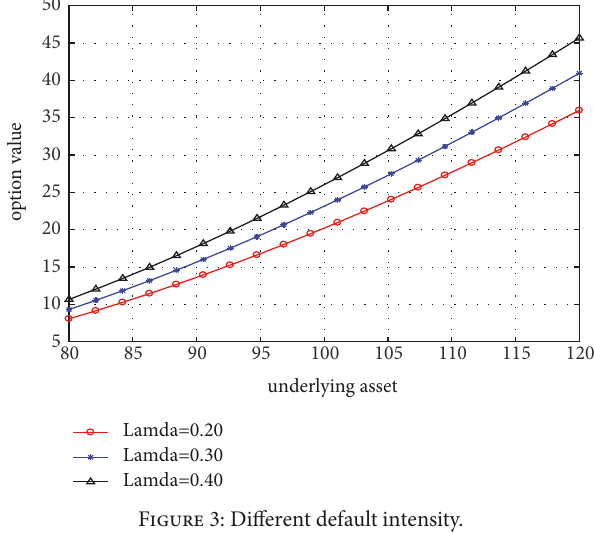
Figure 3: Different default intensity.